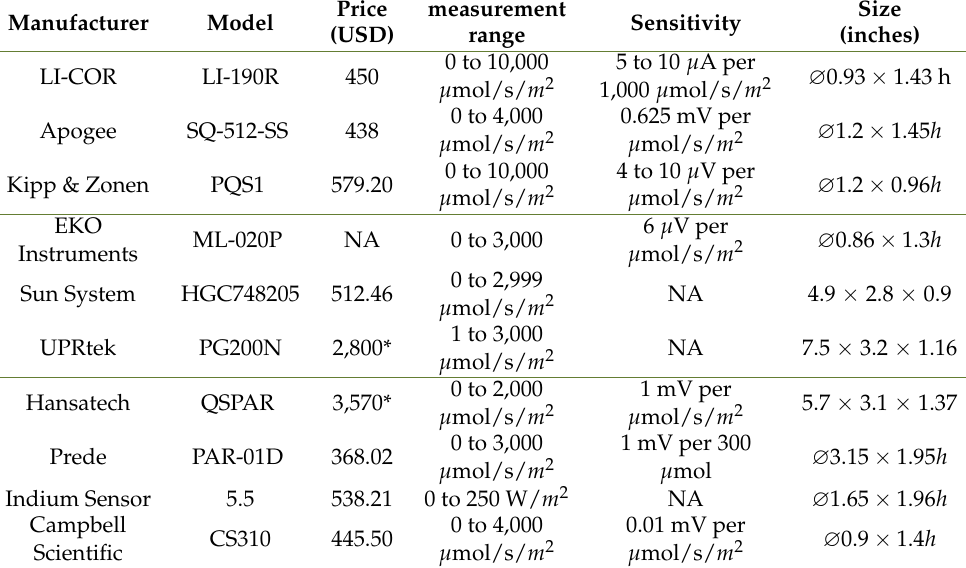
Table 2. Summary of commercial PAR quantum sensors